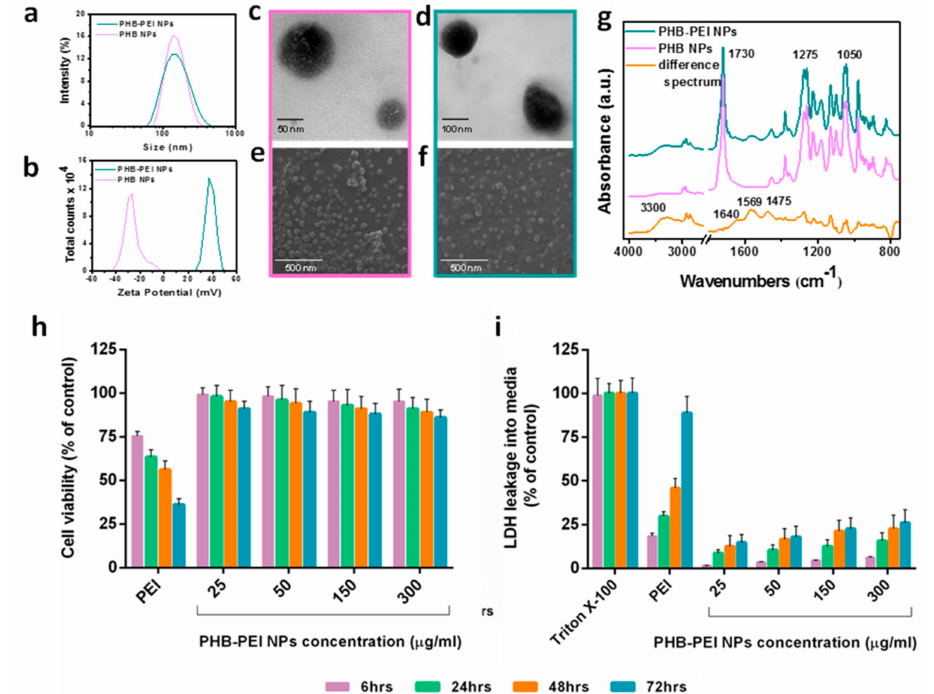
Figure 1. Size, morphological, chemical characterization, and cytotoxicity of PHB based NPs. ( a ) Size distribution and ( b ) zeta potential of PHB and PHB-PEI NPs. TEM and SEM images of: ( c , e ) PHB, and ( d , f ) PHB-PEI NPs. ( g ) FTIR-ATR spectra of PHB and PHB-PEI NPs along with di ff erence spectra. ( h , i ) In vitro cytotoxicity of PHB-PEI NPs. Cytotoxicity was determined in PC3 cells after 6, 24, 48, and 72 h of incubation with varying concentrations of PHB-PEI NPs using: ( h ) the Cell Counting Kit-8 (CCK-8) assay, and ( i ) the Lactate Dehydrogenase (LDH) assay. Untreated cells were used as control. Data are presented as the mean ± SD for three independent